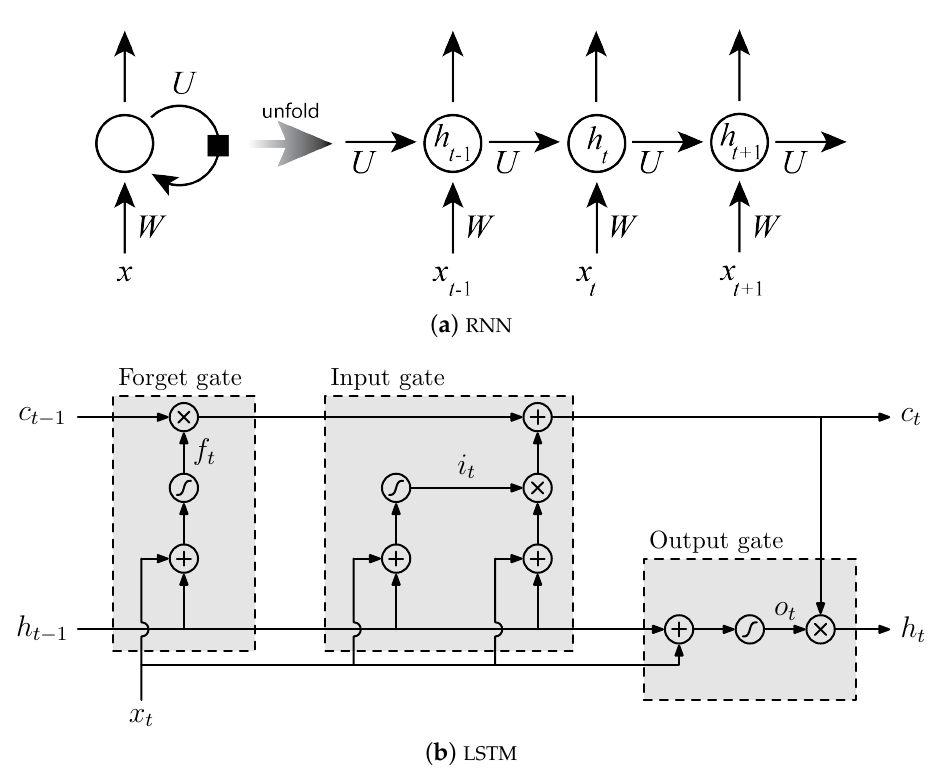
Figure 3. ( a ) A cyclic connection of a recurrent neural network (RNN) folded and unfolded. ( b ) An long short-term memory (LSTM) memory block consisting of one cell at time t and the three gates ( i t , o t , and f t ) which control the activation of the cell c t and its output h t